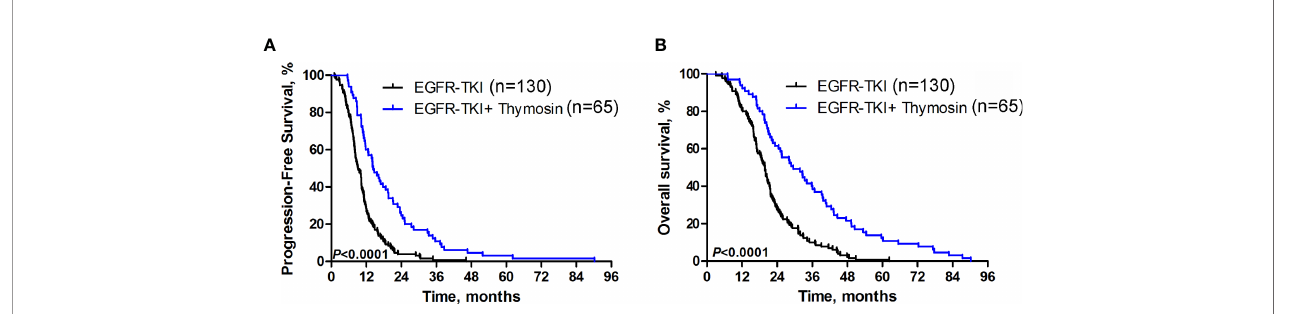
FIGURE 1 | Progression-free Survival and Overall Survival. Kaplan-Meier estimated (A) progression-free survival (PFS) and (B) overall survival (OS) in EGFR-TKI plus thymosin group and EGFR-TKI group.